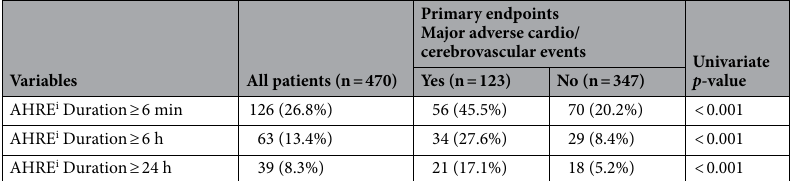
Table 1. Baseline characteristics of the overall study group. Data are presented as medians (interquartile interval) or n (%). Non-parametric continuous variables, as assessed using the Kolmogorov–Smirnov method, were analyzed using the Mann–Whitney U test. Statistical significance is s p < 0.05. a BMI, body mass index; b EF, ejection fraction; c LVEF, left ventricular ejection fraction; d LA, left atrium; e RV, right ventricle; f non-DHP CCBs, non-dihydropyridine calcium channel blockers; g RAAS inhibitors SGLT inhibitors; h SGLT2, sodium glucose co-transporters 2; i AHRE, atrial high-rate episodes.